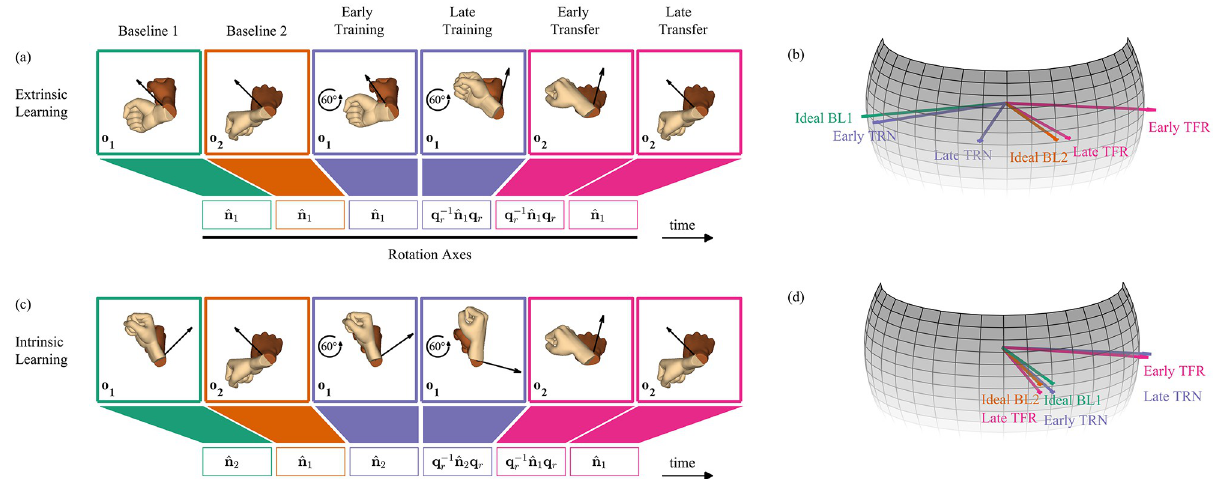
Fig 4. Hypotheses of learning and generalization of a visuomotor rotation – the case of orientation-matching. (a)-(b) Extrinsic learning hypothesis —transfer of learning of an extrinsically represented axis. (c)-(d) Intrinsic learning hypothesis—transfer of learning of an intrinsically represented axis. The dark and light hands represent the expected initial and final orientations of the hand, respectively. The black rotation axes are drawn with respect to an extrinsic reference frame. The colors are as in Fig 3. If participants adapt to the visuomotor rotation while training, their aim is expected to gradually deviate from the ideal BL1 axis in the direction opposite to that of the perturbation. If participants transfer the perturbation across orthogonal initial orientations, their aim is expected to deviate in the same direction from the ideal BL2 axis in the early transfer trials. The spheres present the hypotheses regarding the hand rotation axis in an intrinsic reference frame at each key trial. The early TRN axis may deviate from the ideal BL1 axis due to corrections. Axes which are ideally equal, such as the ideal BL1 and ideal BL2 axes in (d), were separated for better visualization.